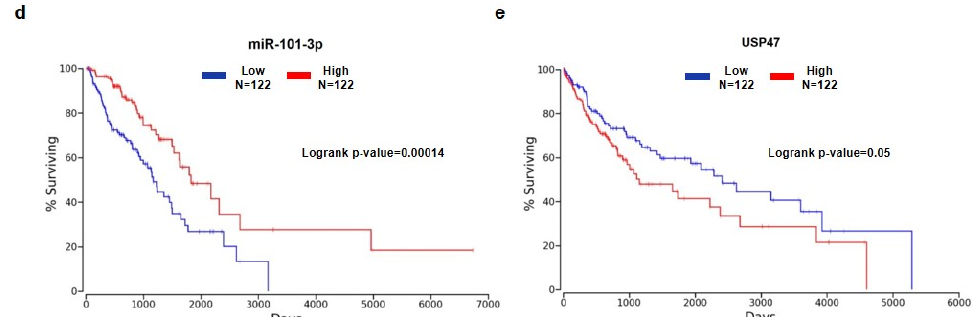
Figure 7. MiR-101-3p is downregulated in lung cancer. ( a ) USP47 expression level was analyzed in adjacent normal tissues ( n = 43) and lung cancer tissues ( n = 33, n = 9) (GSE40275). ( b , c ) MiR-101-3p expression levels were analyzed in: ( b ) adjacent normal tissues ( n = 5) and lung cancer tissues ( n = 119) (GSE51853); and ( c ) control ( n = 19) and patient ( n = 17) blood samples (GSE17681). ( d , e ) Kaplan–Meier analysis of survival rates according to: ( d ) miR-101-3p; or ( e ) USP47 expression in lung cancer patients performed using the TCGA database at the OncoLnc site. The data in parts ( a – c ) represent the mean ± SD (** p < 0.005, *** p < 0.001, t